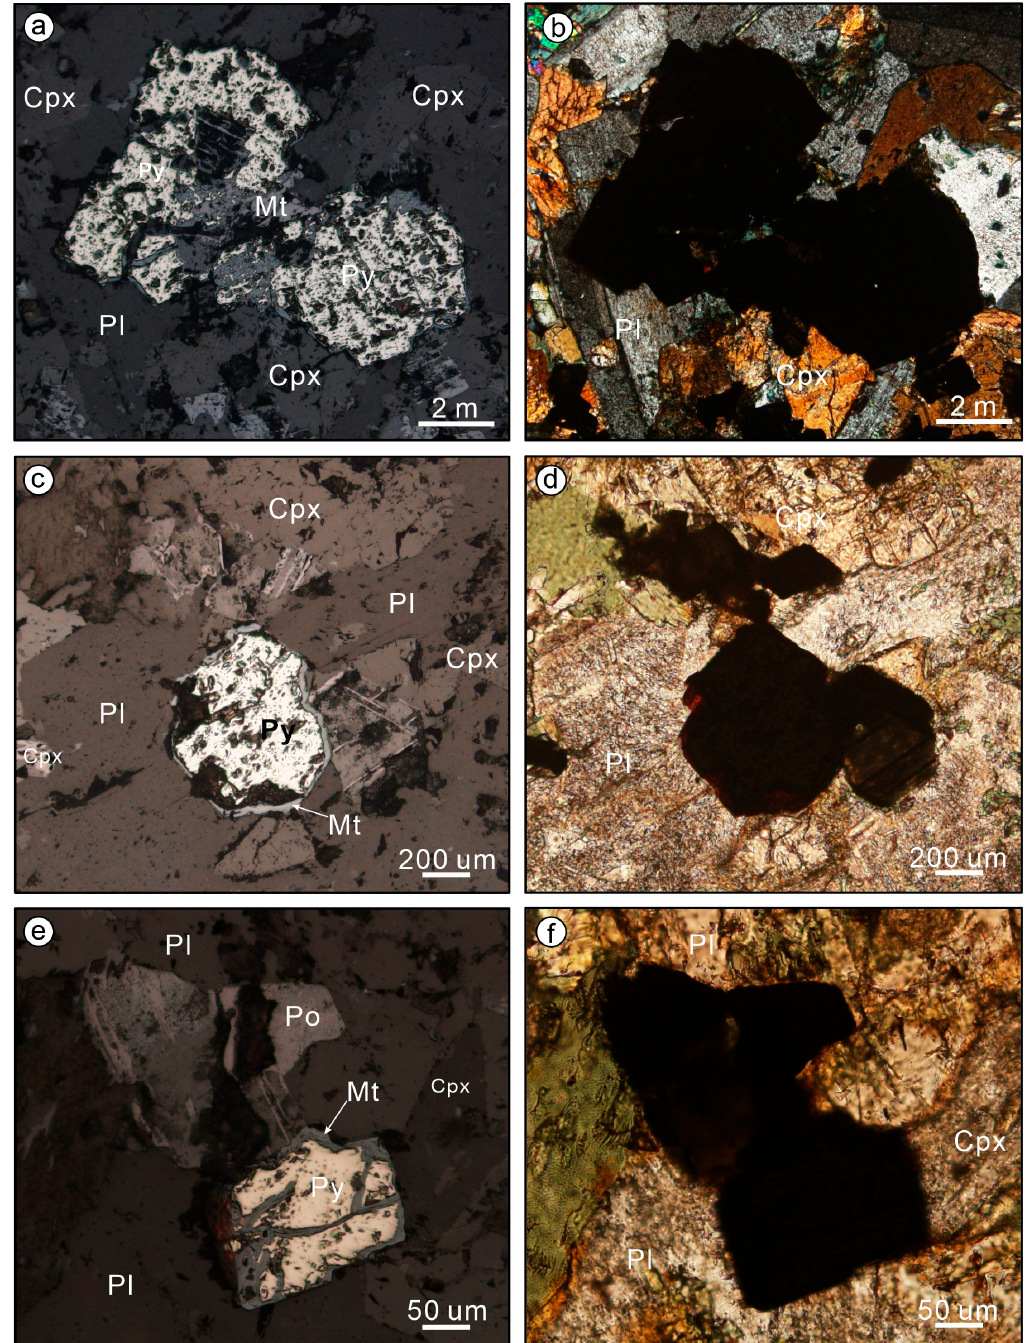
Figure 4. Photomicrographs showing the sulfide phases in the diabase dykes of the Aksu area. ( a,b ) Pyrite grains are generally intergrown with magnetite and silicates in plagioclase and clinopyroxene; ( c,d ) subhedral pyrite grains enveloped by magnetite rims; ( e,f ) pyrrhotite, pyrite, and magnetite within plagioclase of the diabase dykes. Abbreviations: Pl = plagioclase, Cpx = clinopyroxene, Py= pyrite, Po = pyrrhotite, Mt = magnetite.